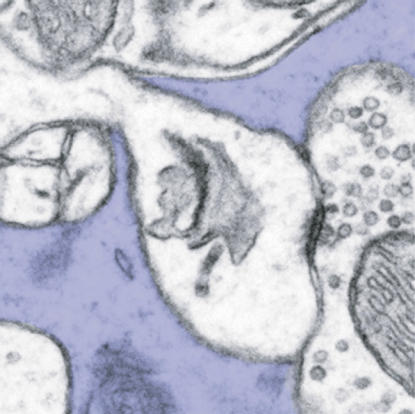
Electron micrograph of a dendritic spine synapsing with an axonal bouton and ? anked on either side by an astrocytic process (blue).